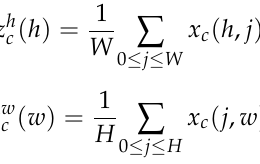
Figure 10. Schematic diagram of CA attention mechanism module.